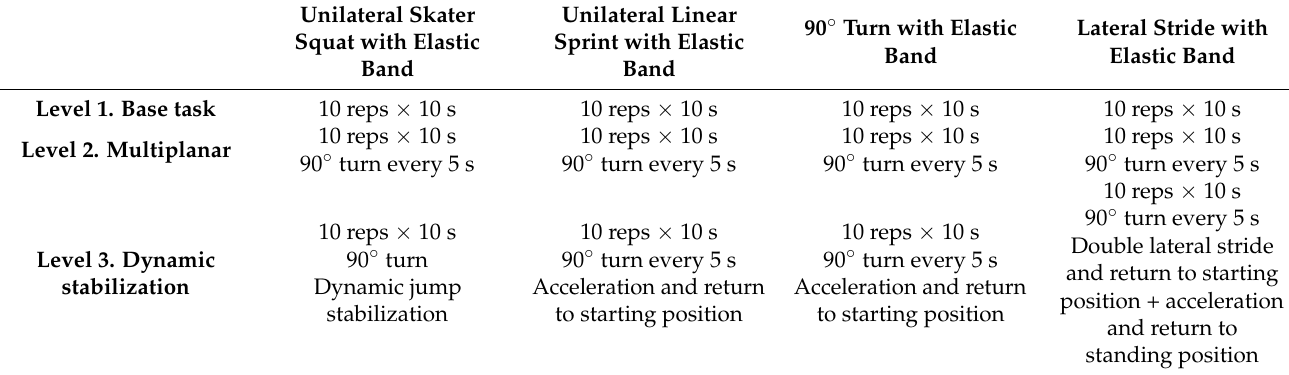
Table 5. Progression of the training tasks of the SCS group during the 8-week training